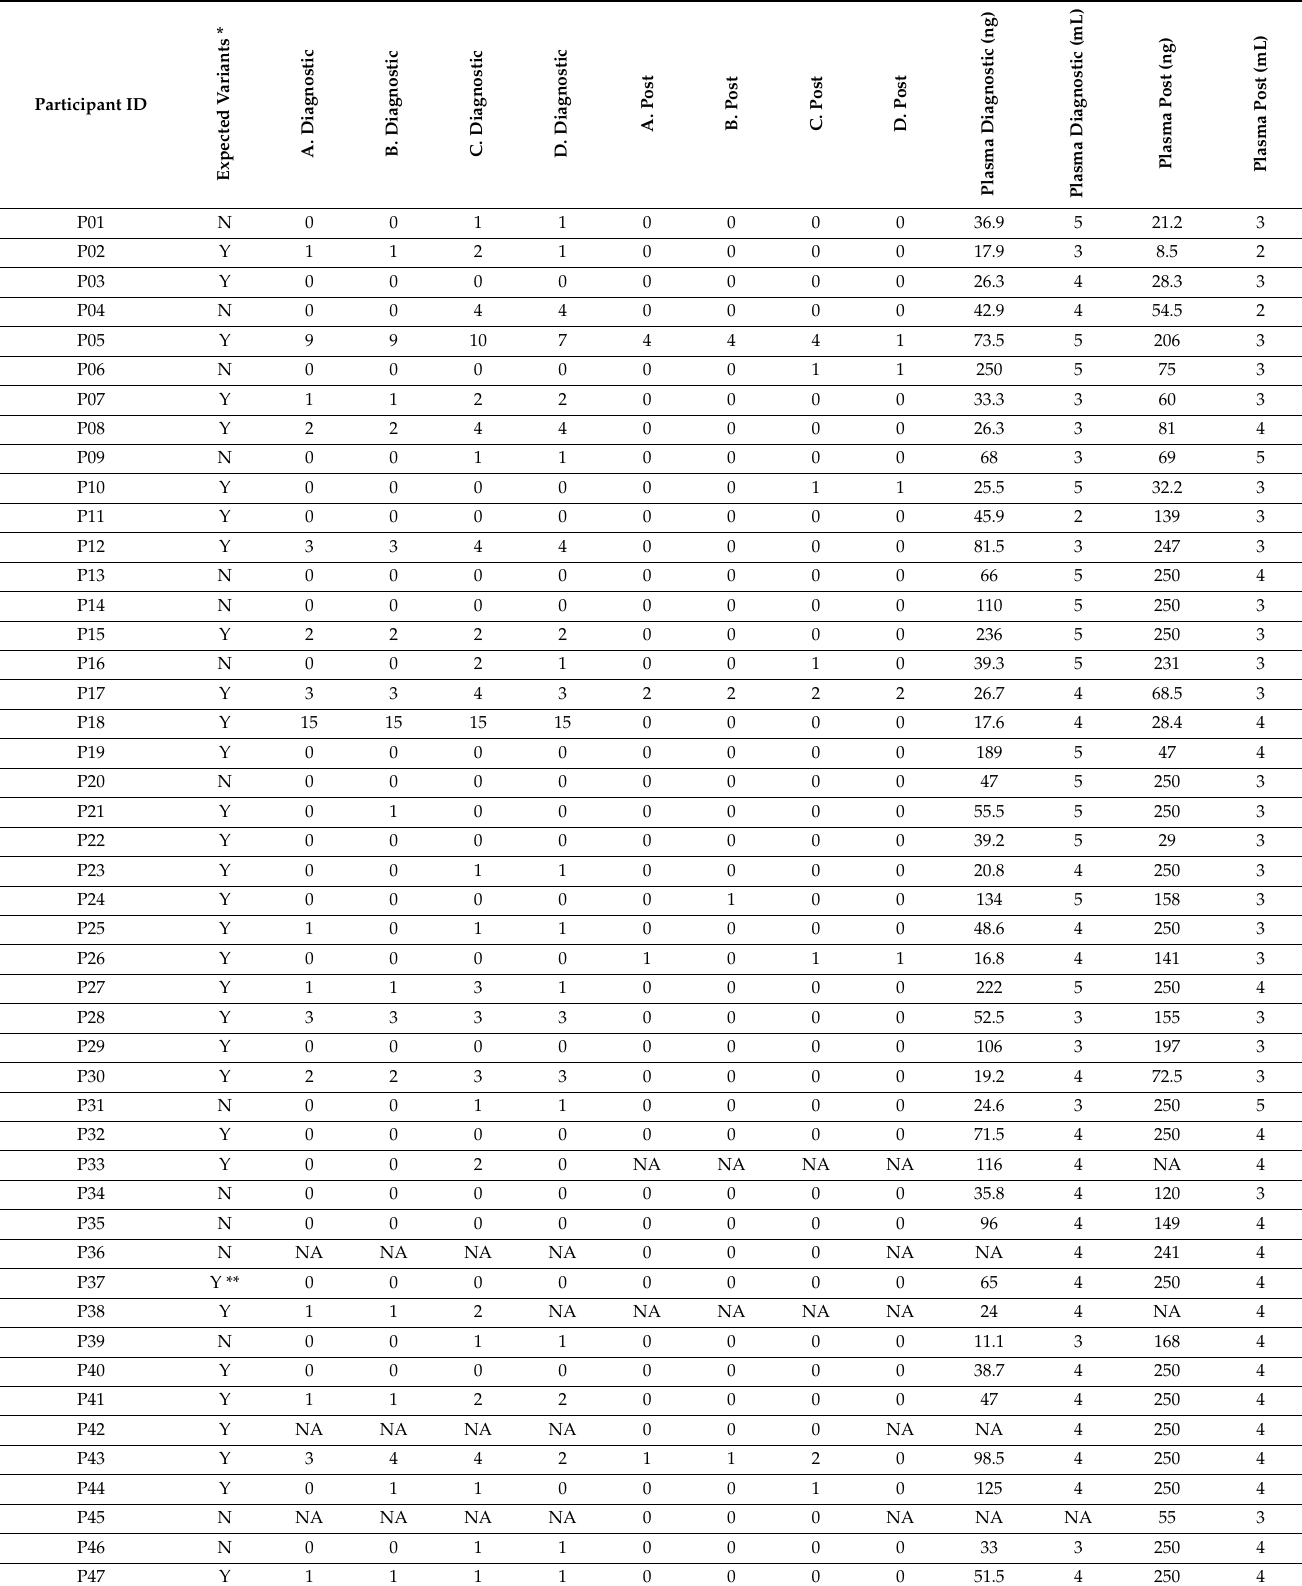
Table 2. Number of ctDNA variants per approach, and participants and the final amounts of plasma and DNA